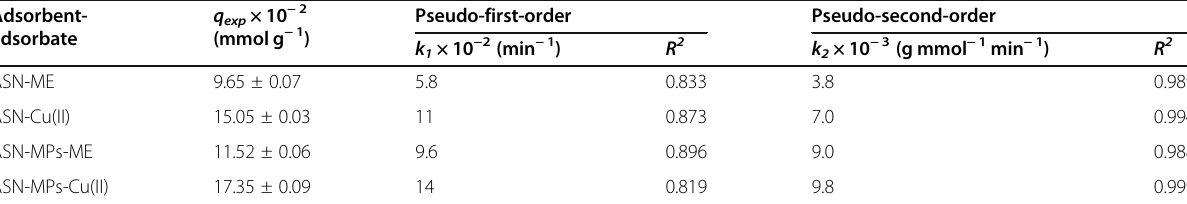
Table 1 Kinetic parameters of the ME and Cu(II) cations adsorption on ASN and ASN-MPs at 27 °C and pH 7 Adsorbent- adsorbate